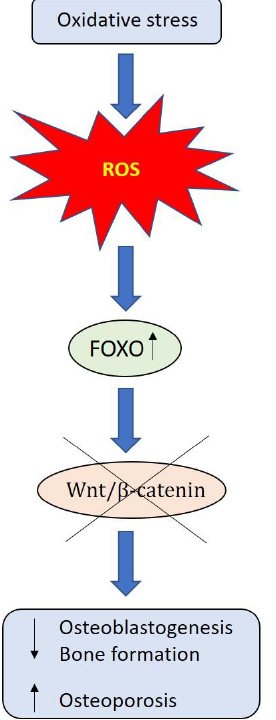
Figure 2. Oxidative stress determines the bone loss associated with bone ageing. The reactive oxygen species (ROS)-activated FOXO (Forkhead box O) transcription divert β -catenin away from Wnt signaling pathway, leading to decreased osteoblastogenesis.